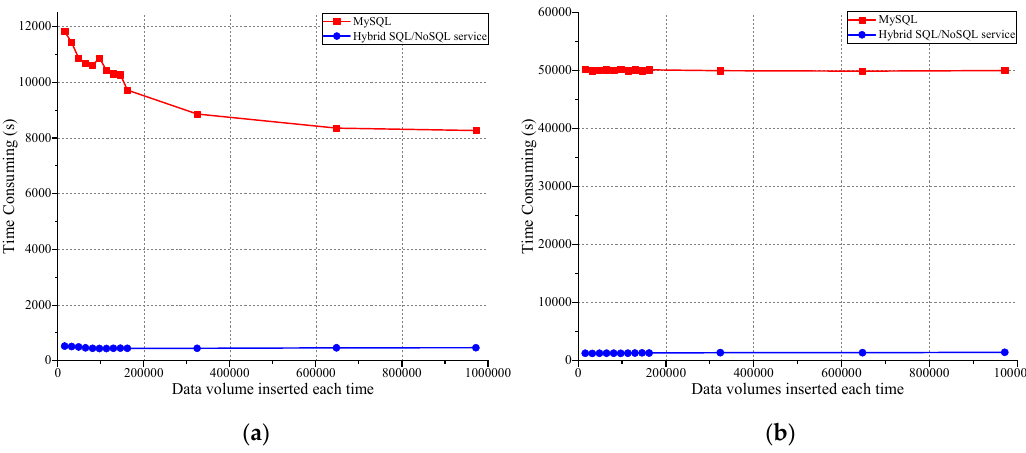
Table 2. Storage strategies and experimental data.